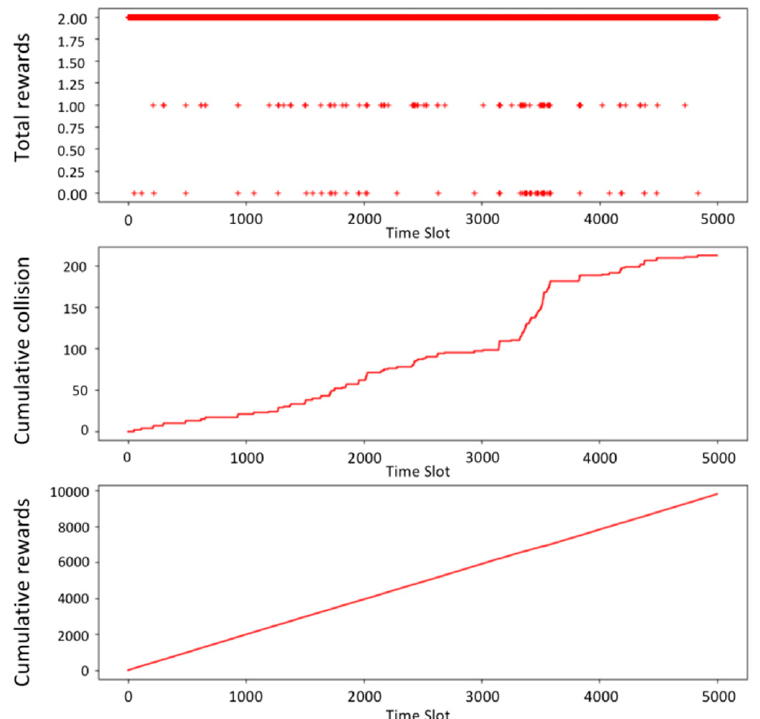
Figure 6. When K = 2 and N = 3, the total reward, cumulative collision, and cumulative reward for the last 5000 time slots.